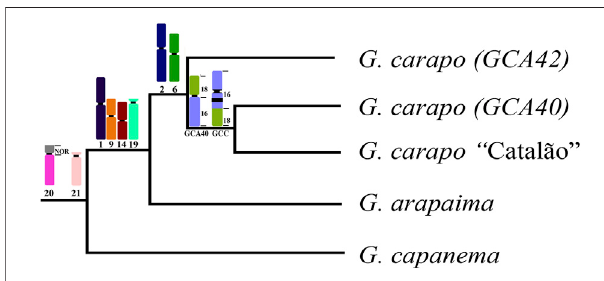
FIGURE 4 | Representative phylogeny based on da Silva et al. (2019), with the syntenic blocks shared by the nodes. Chromosome numbers refer to the G. carapo 2n = 42 chromosomes (see Figure 3